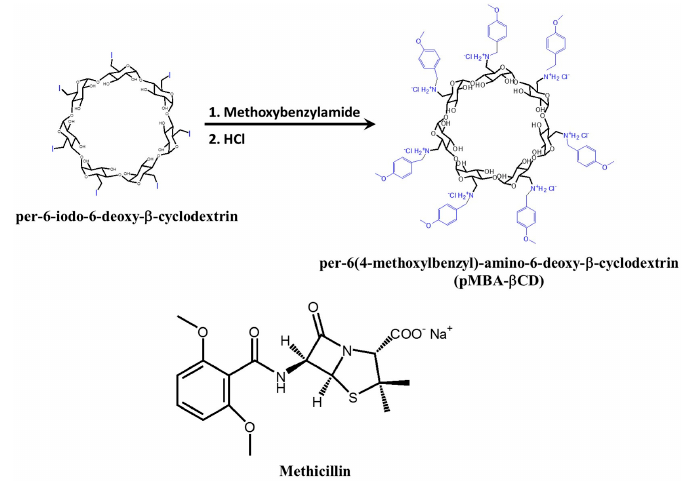
Figure 1. Synthesis of pMBA- β CD starting from per-6-iodo-6 β -cyclodextrin and the chemical structure of methicillin.